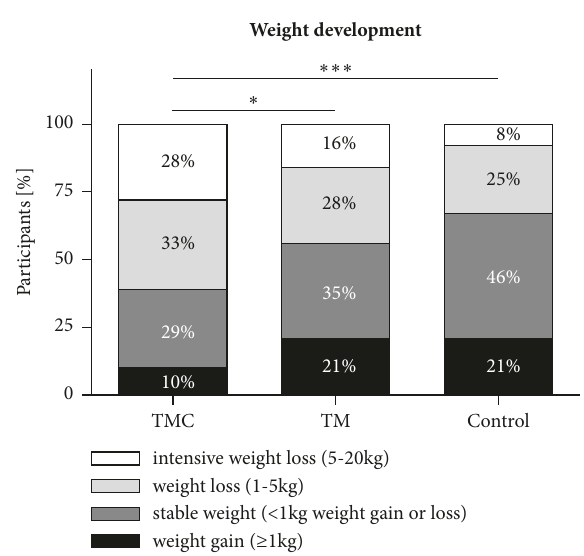
Figure 2: Weig h t c h ange s an d d i ff erence s a ft er 12 wee ks o f intervention . Participants of thetelemedicalcoaching(TMC;n=58) group, the telemedical (TM; n=61) group, and the control group (n=61)wereclassifiedaccordingtotheirweightchangeafter12weeks of intervention into one of four categories: (1) ≥ 1 kg weight gain (black), (2) stable weight with < 1 kg weight change (dark grey), (3) weightloss of 1-5 kg (lightgrey), or (4)weightloss of 5-20 kg (white). Shown are percentages. Differences in frequency distribution of Chi square test ( ∗ , p < 0.05; ∗ ∗ ∗ , p < 0.001).